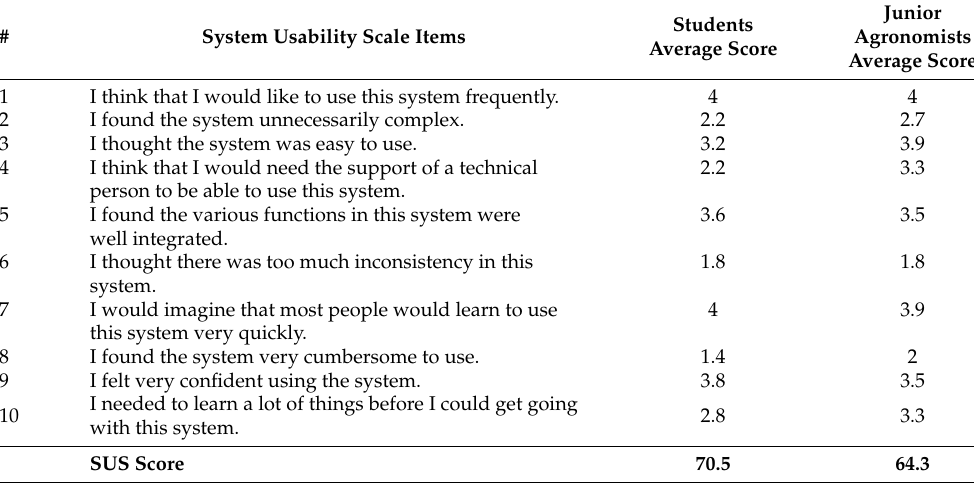
Table A3. The usability testing of RiceMan based on the System Usability Scale (SUS), evaluated by junior agronomists and